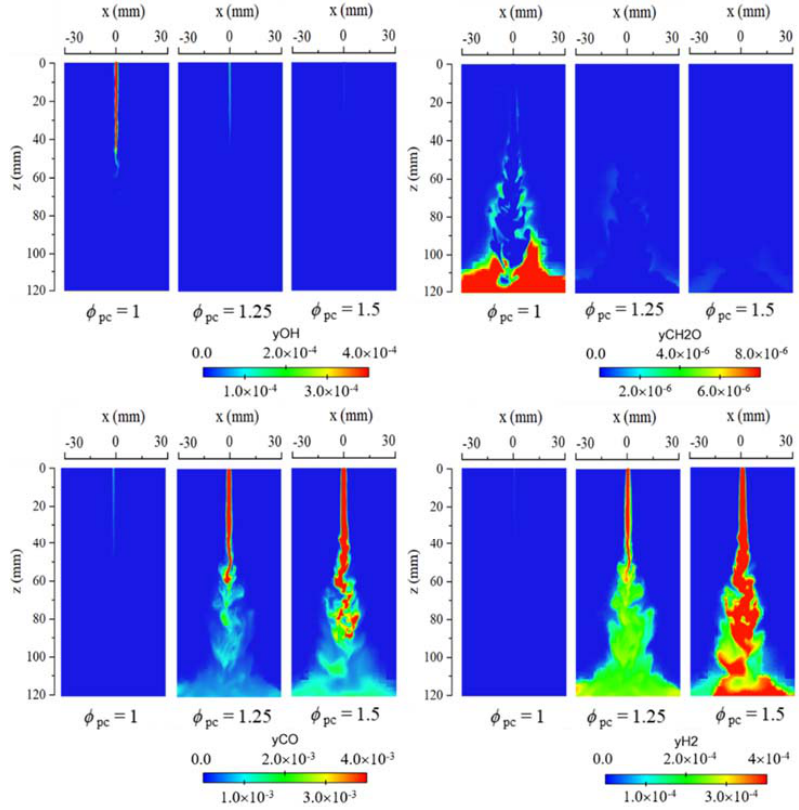
Figure 13. Distribution of major species in the jet for different prechamber global equivalence ratios at 3 ms after the hot jet